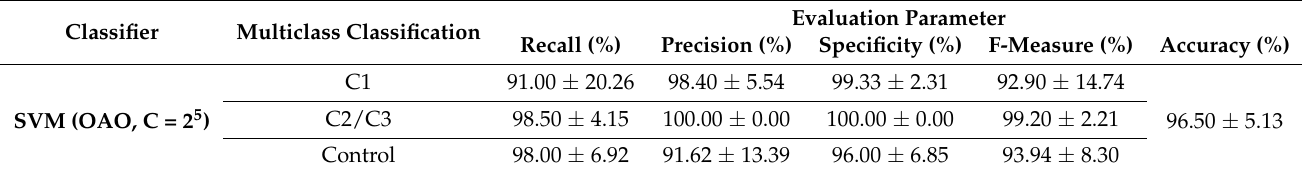
Table 5. Multiclass classification results considering NASA-TLX labeling.